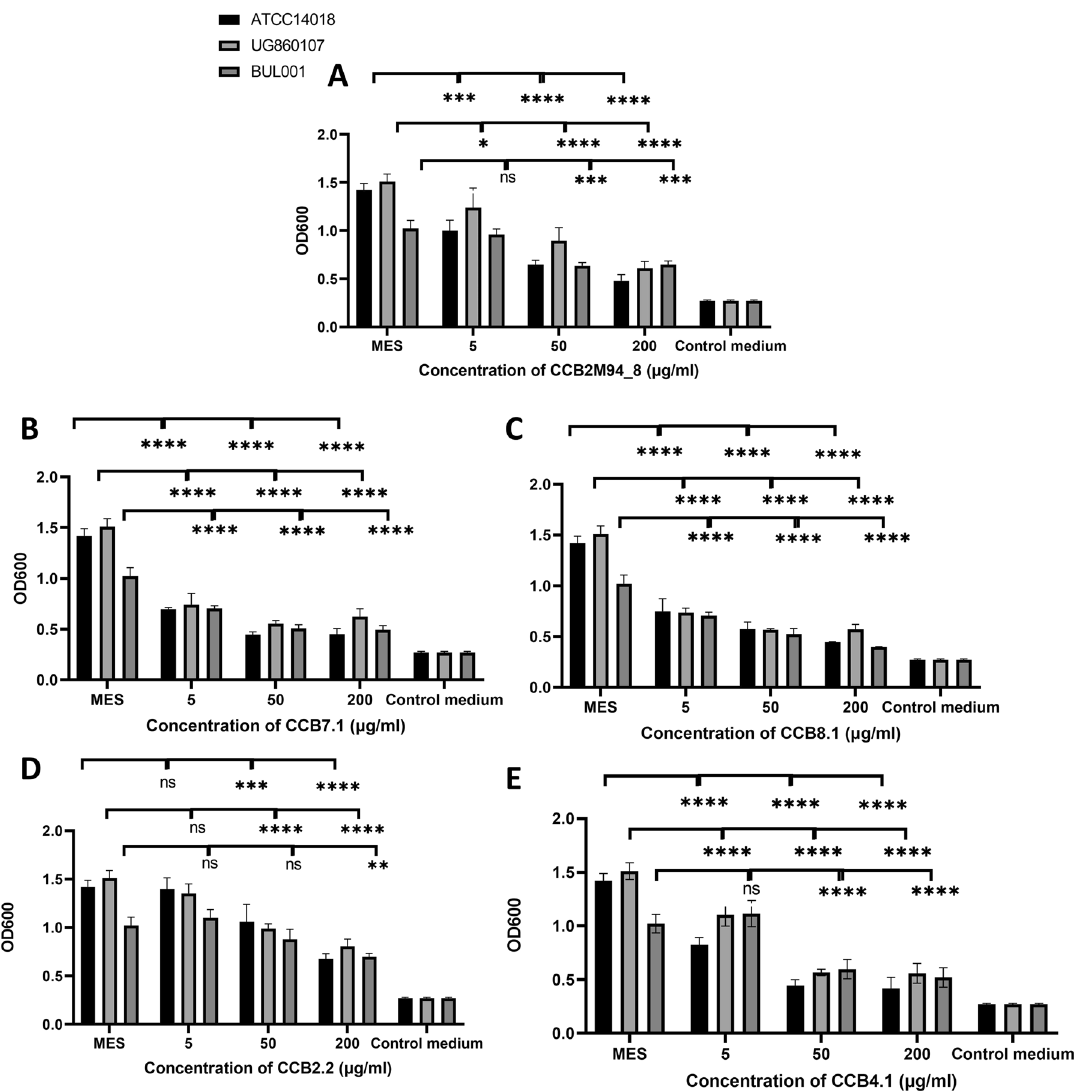
Fig. 4 Endolysin bio fi lm disruption activity : Bio fi lm disruption assay using G. vaginalis ATCC14018, G. vaginalis UG860107 and G. vaginalis BUL001 bio fi lms. Final concentrations of A CCB2M94_8, B CCB7.1, C CCB8.1, D CCB2.2 or E CCB4.1, from 5 to 200 μ g/ml were used to disrupt bio fi lms. OD 600 readings are the average of biological triplicates plus/minus their standard deviation. The asterisks in fi gures indicate levels of signi fi cance. p -values < 0.05 are represented by *, p- values < 0.01 are represented by **, p -values < 0.001 are represented by *** , and p -values < 0.0001 are represented by ****. No statistical differences are represented by ns. Controls: MES corresponds to bacteria with MES buffer and control medium is the no bacterial control. p -values for ANOVA and Tukey